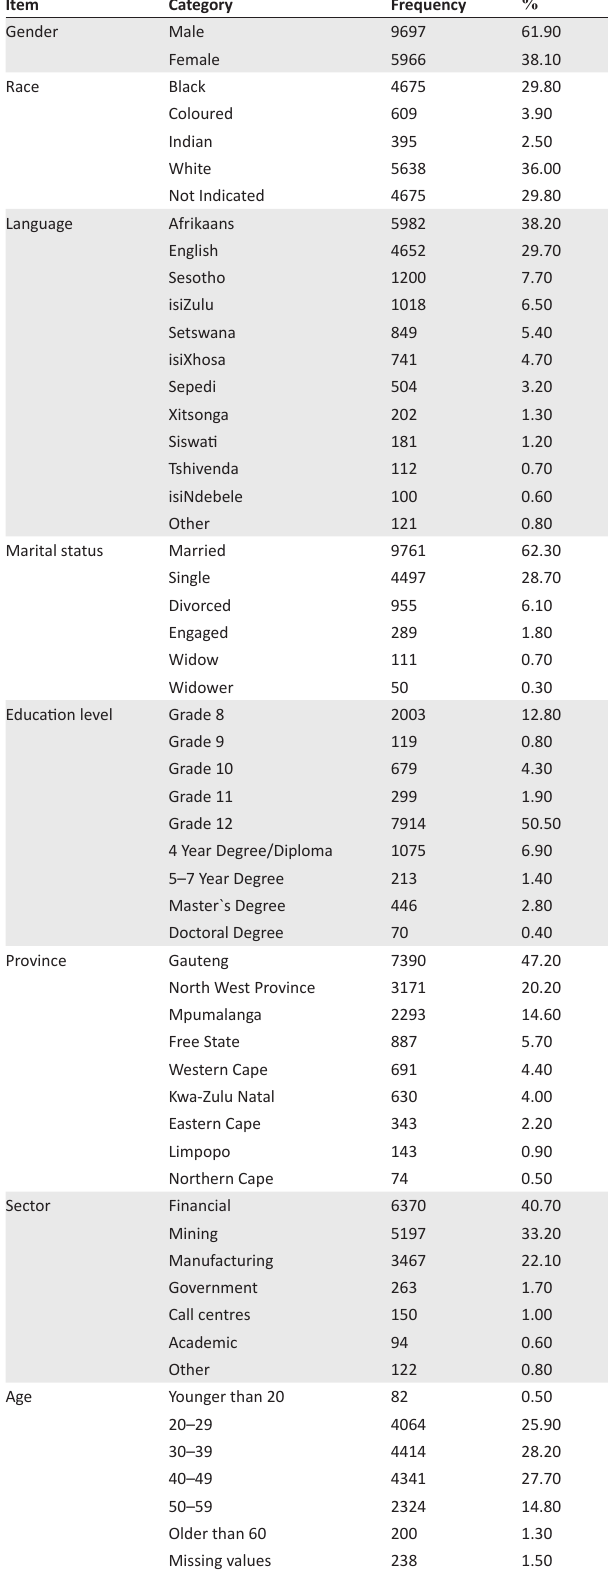
TABLE 1: Characteristics of the participants ( n = 15